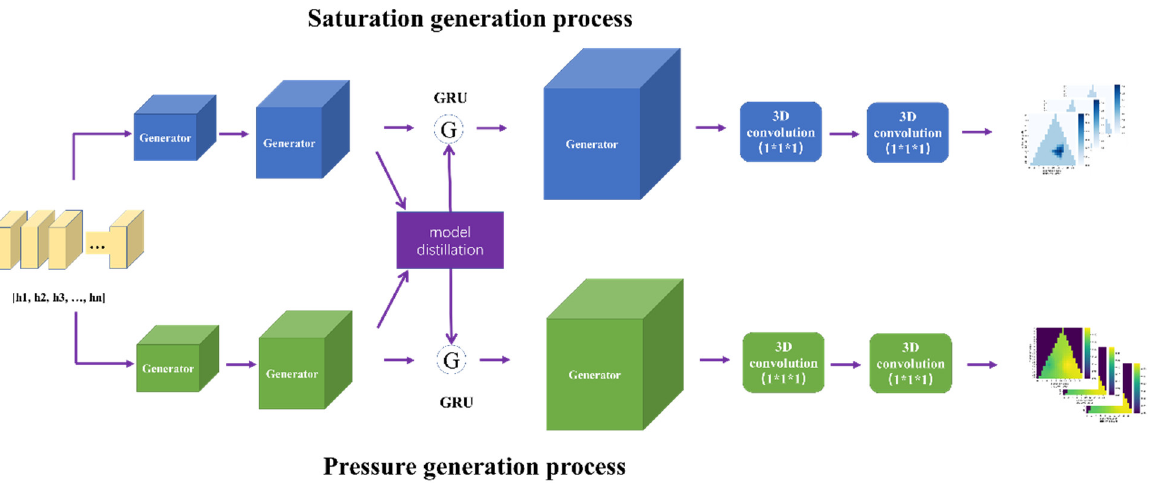
Figure 4. The structure of the Decoder network.